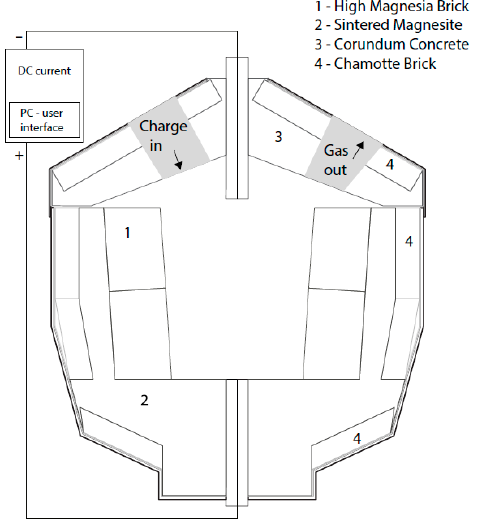
Figure 1. Cross-section of the laboratory scale DC electric arc furnace. Figure 1. Cross ‐ section of the laboratory scale DC electric arc furnace.